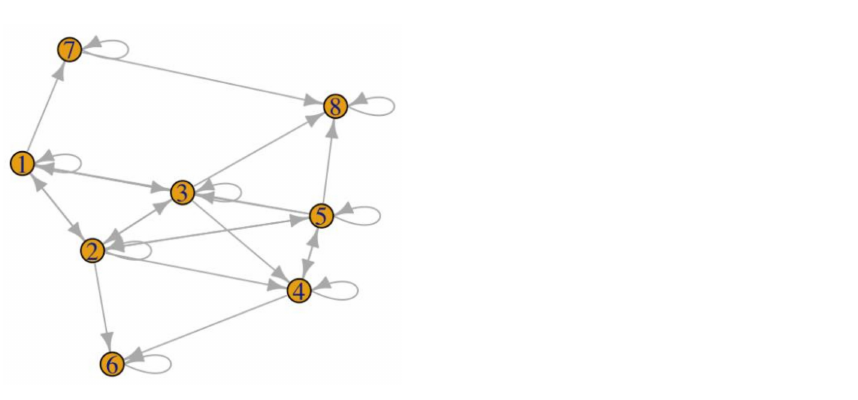
Figure 1. Example of a graph generated from an adjacency matrix with 8 different types of drugs. This is not an example based on real data, but it may be considered a plausible situation. The eight nodes may represent eight different types of pharmaceutical equivalent drugs (i.e., same active ingredients, same dosage form and method of administration, identical in concentration/strength), branded or not. A sample of patients in a given interval of time switched between these different drugs, as represented in the adjacency matrix of Figure